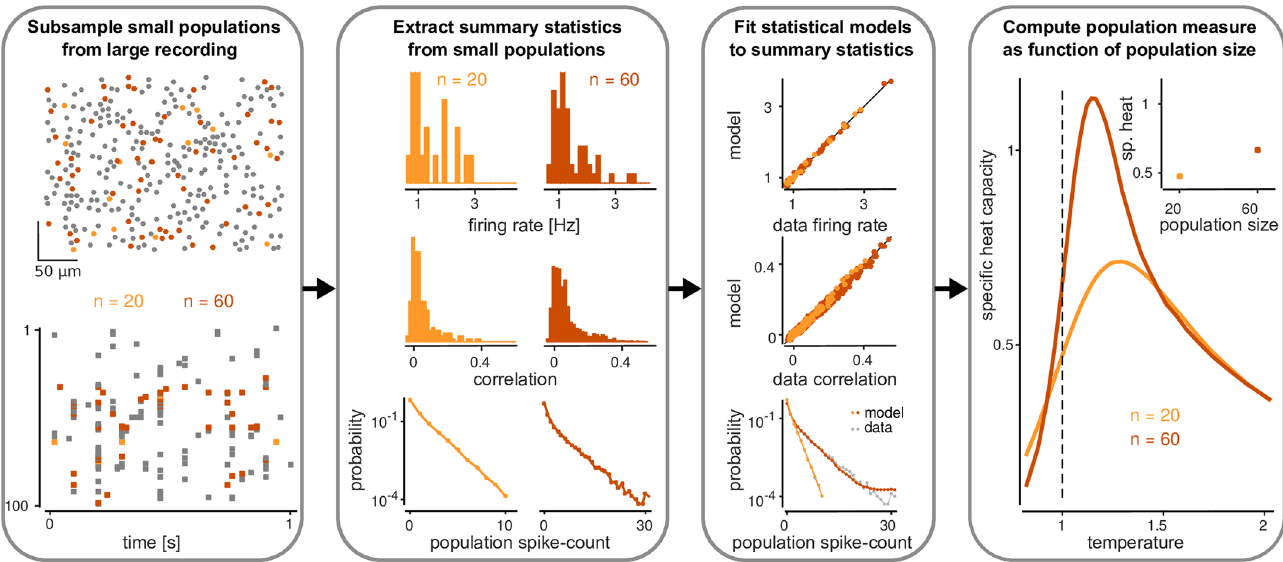
Fig 1. How can one relate theories of thermodynamic criticality to the statistics of neural data? In physicalsystems, the divergenceof specific heat with system size can be interpreted as the system being at a critical point. We here study an analysisapproach that has beenproposedin order to search for similar signaturesof criticality in the statistics of neuralpopulationactivity. In this approach,different populationsare subsampled from a large recordingand summary statistics are extracted for each subpopulation (e.g. firing rates, correlationsand population spike count statistics). Subsequently, maximum entropy models are fit to these data which assign a probabilityto each possiblespike-pattern. Exploiting the mathematical relationshipbetweenthe log-variance of probabilities (in statistics) and the specific heat (in thermodynamics) then allows one to compute and study the behaviourof the specific heat with population size. The goal of this study is to determineunder which conditions (i.e., for which firing rates and correlations)such an analysiswouldreport that the system is critical. To this end, we apply this approachto a simulationof neuralpopulationactivity and analytically tractable